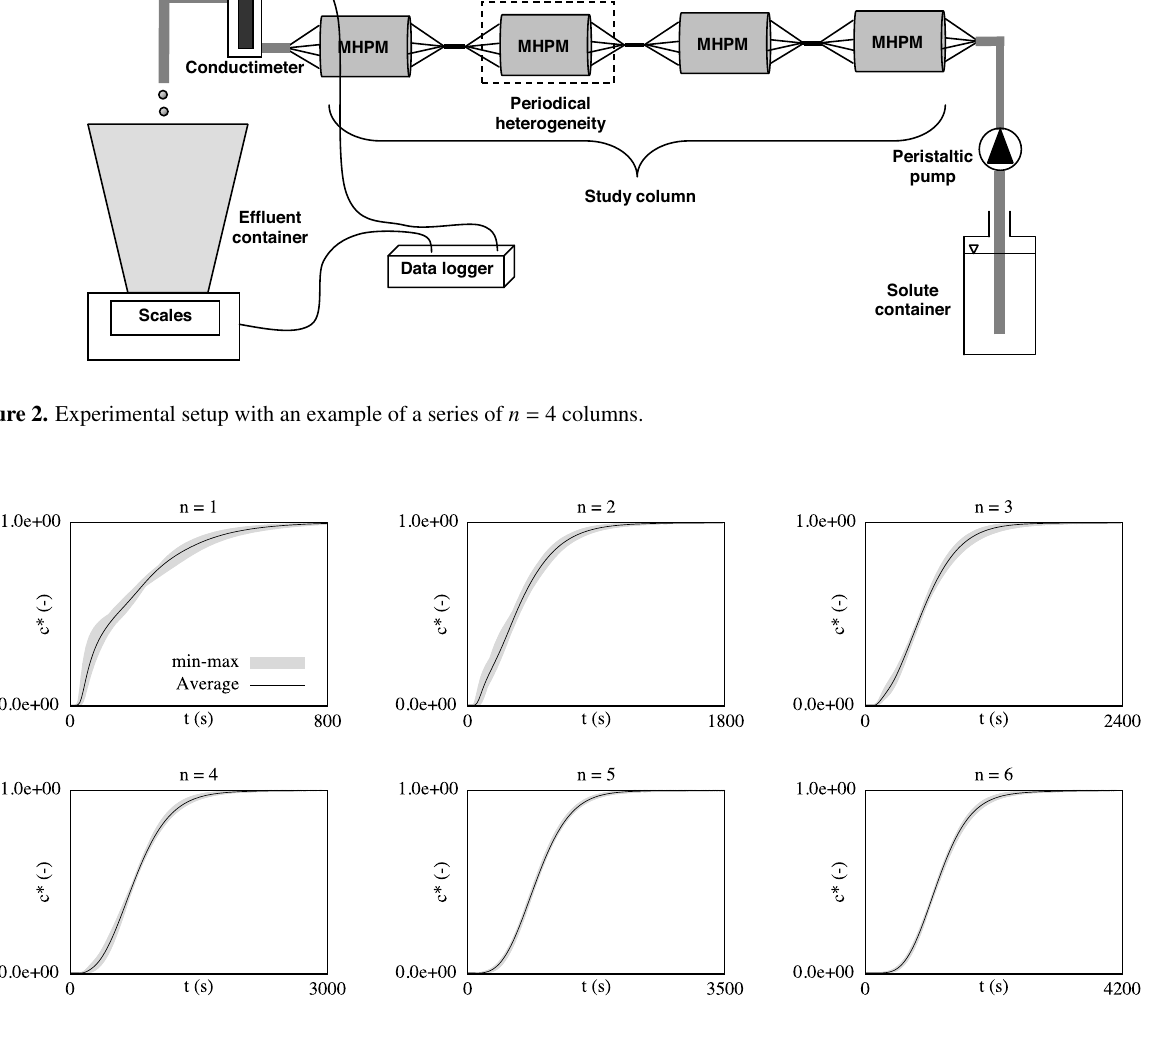
Figure 3. Experimental breakthrough curves for n = 1 to 6